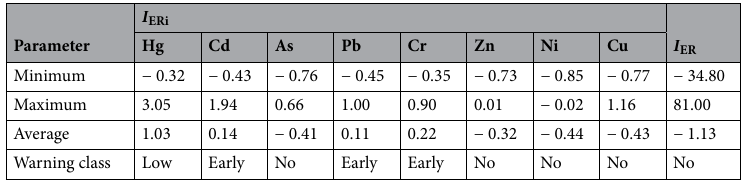
Table 8. Warning of ecological risks of heavy metals in surface soil within the research area.